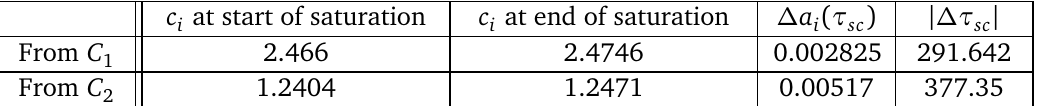
Table 3: Estimated lower bound values of scrambling time scales for the region of saturation in cosine hyperbolic case from the two different